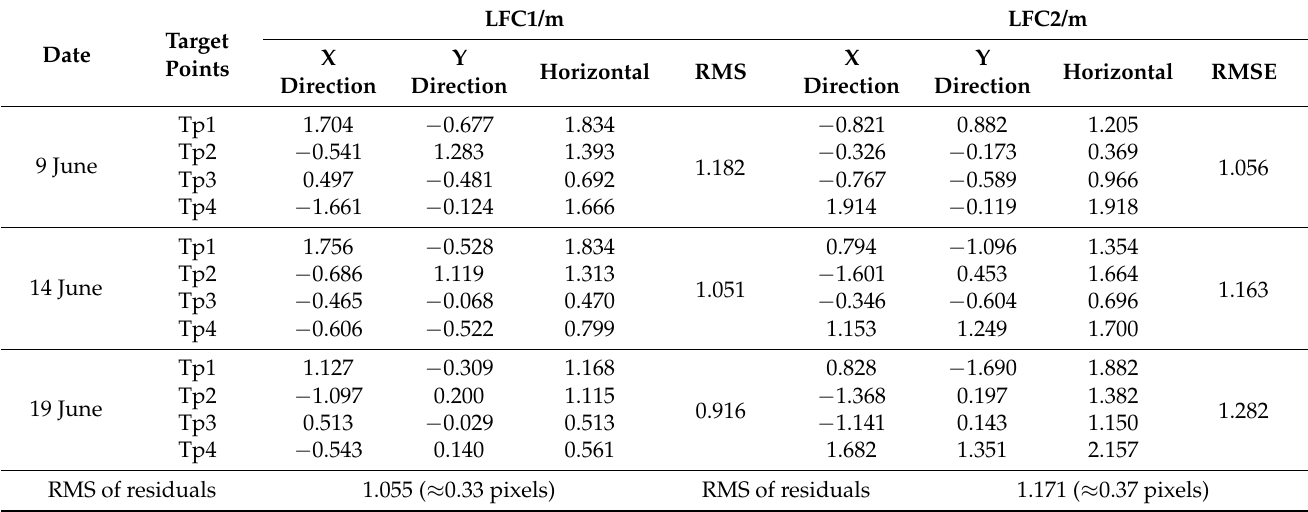
Table 4. Validation results for internal calibration of laser footprint cameras (LFCs).